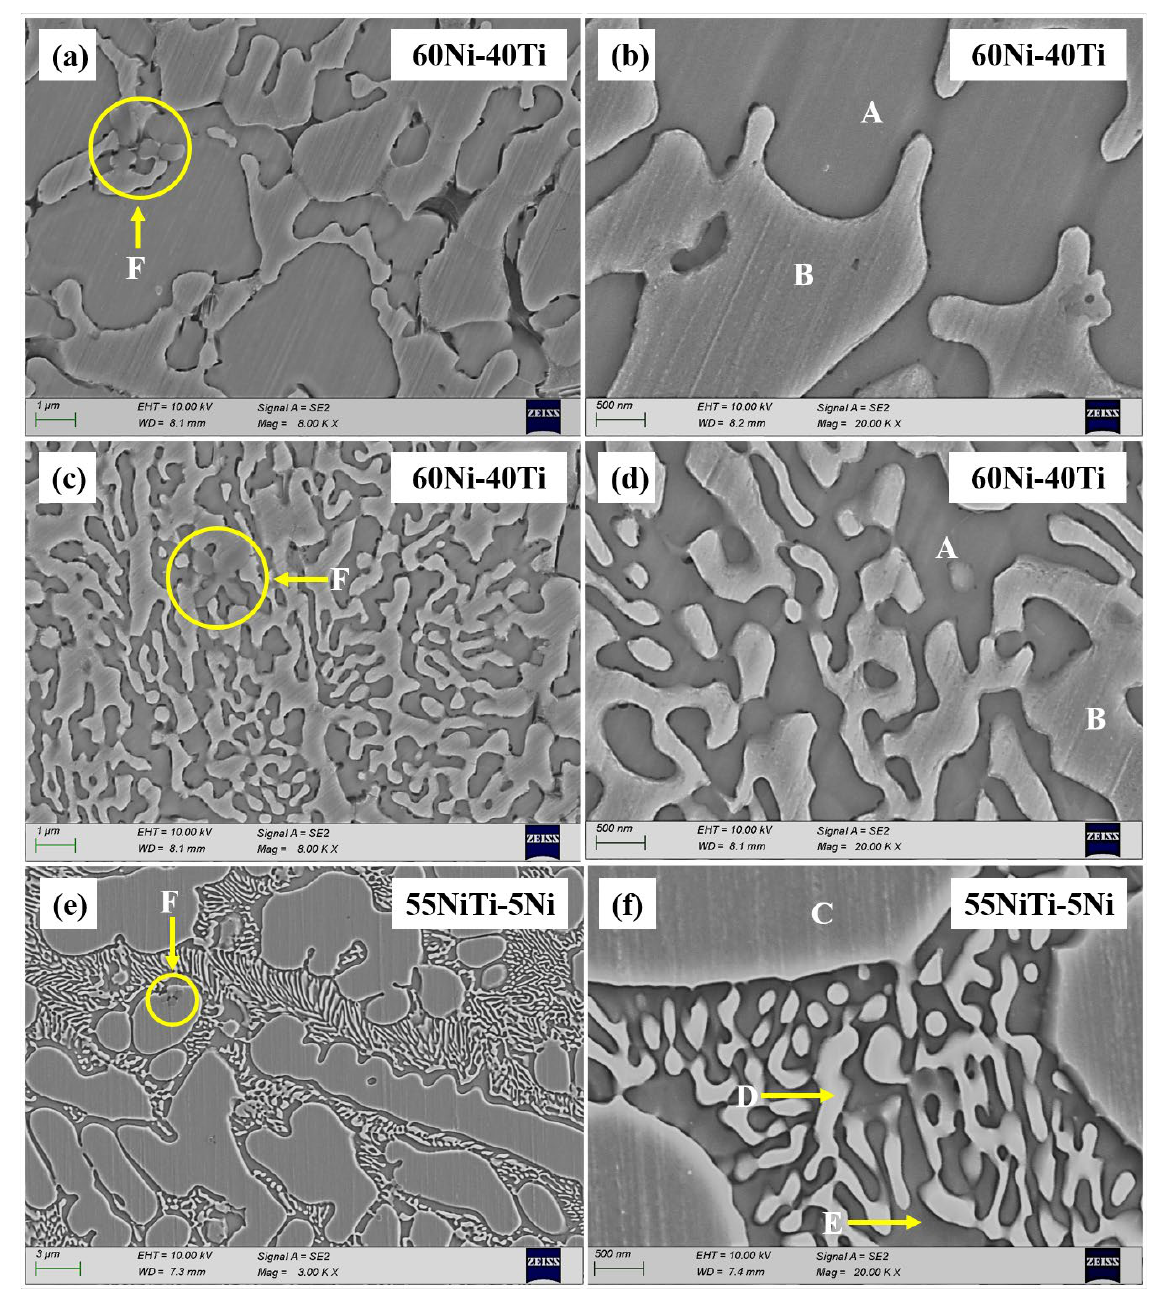
Figure 6. SEM images of the Top area: ( a )–( d ) 60Ni-40Ti; ( e )–( f ) 55NiTi-5Ni. Table 3. The result of the elemental composition of zones A–E in Figure 6.